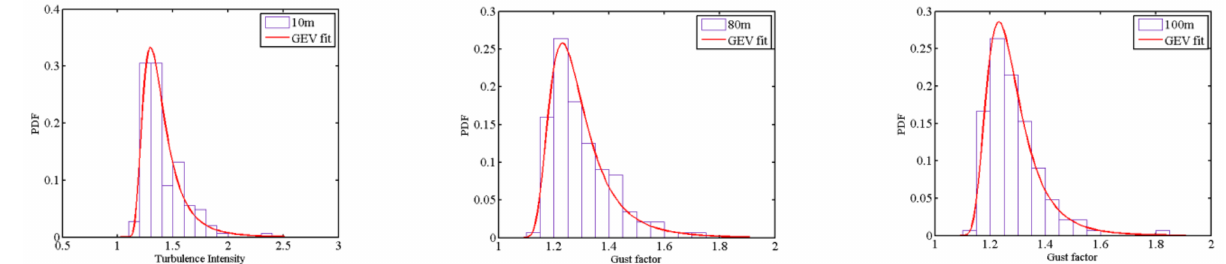
Figure 16. Gust factor fitted by the GEV distribution.